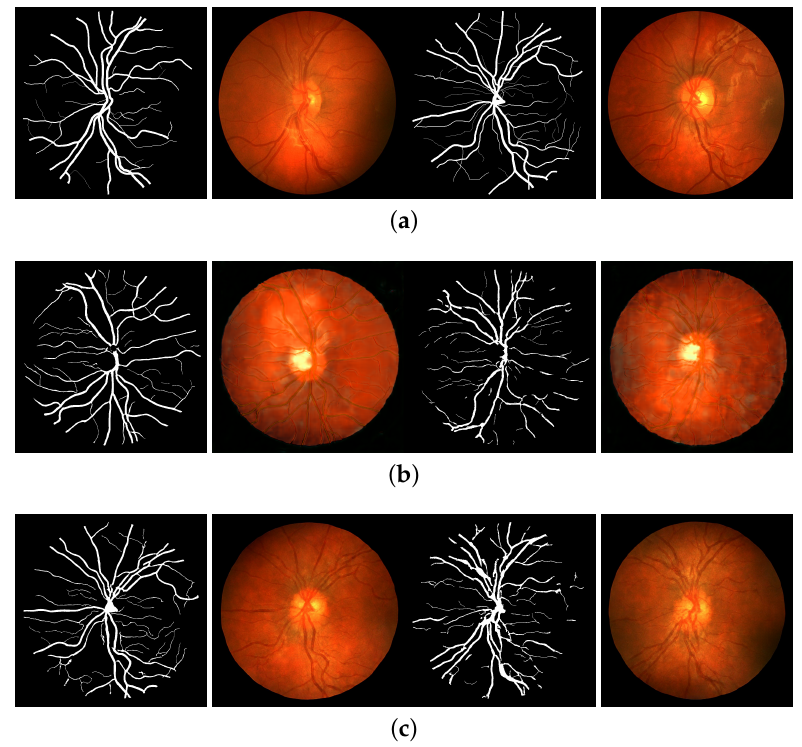
Figure 7. Examples of real and generated CHASE_DB1 images. ( a ) Generated CHASE_DB1 images with our two-step method; ( b ) Generated CHASE_DB1 images with the single-step method; ( c ) Real CHASE_DB1